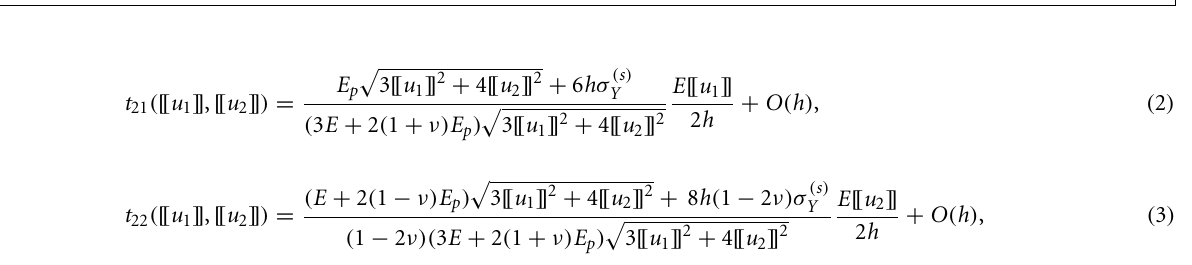
FIGURE 3 | (A) A shear band inside a ductile material modeled as a thin layer of highly compliant material ( E ep / E (cid:28) 1) embedded in a material block characterized by a dimension H , such that h / H (cid:28) 1; both materials obey the